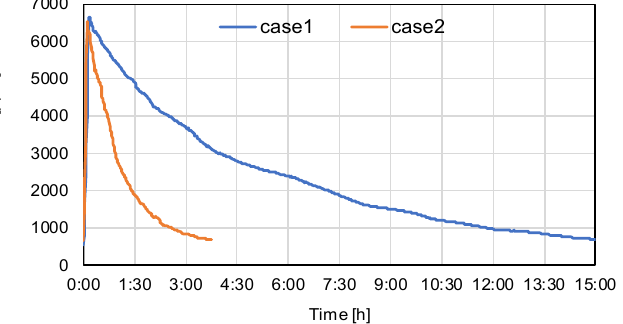
Figure 3. Carbon dioxide concentrations with and without a ventilation fan (conditions 1 and 2).